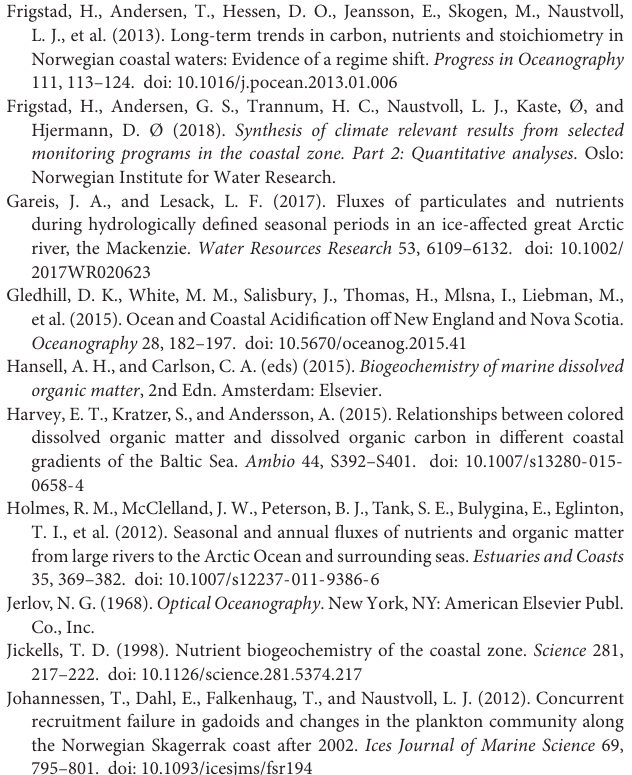
FIGURE S2 | Depth profiles from 0 to 30 m of NH 4 -N ( µ g L − 1 ) for coastal stations in study region: (A) Outer Oslofjord/southern Norway, (B) Runde/western Norway, and (C) Malangen/northern Norway. Data are interpolated with actual data points